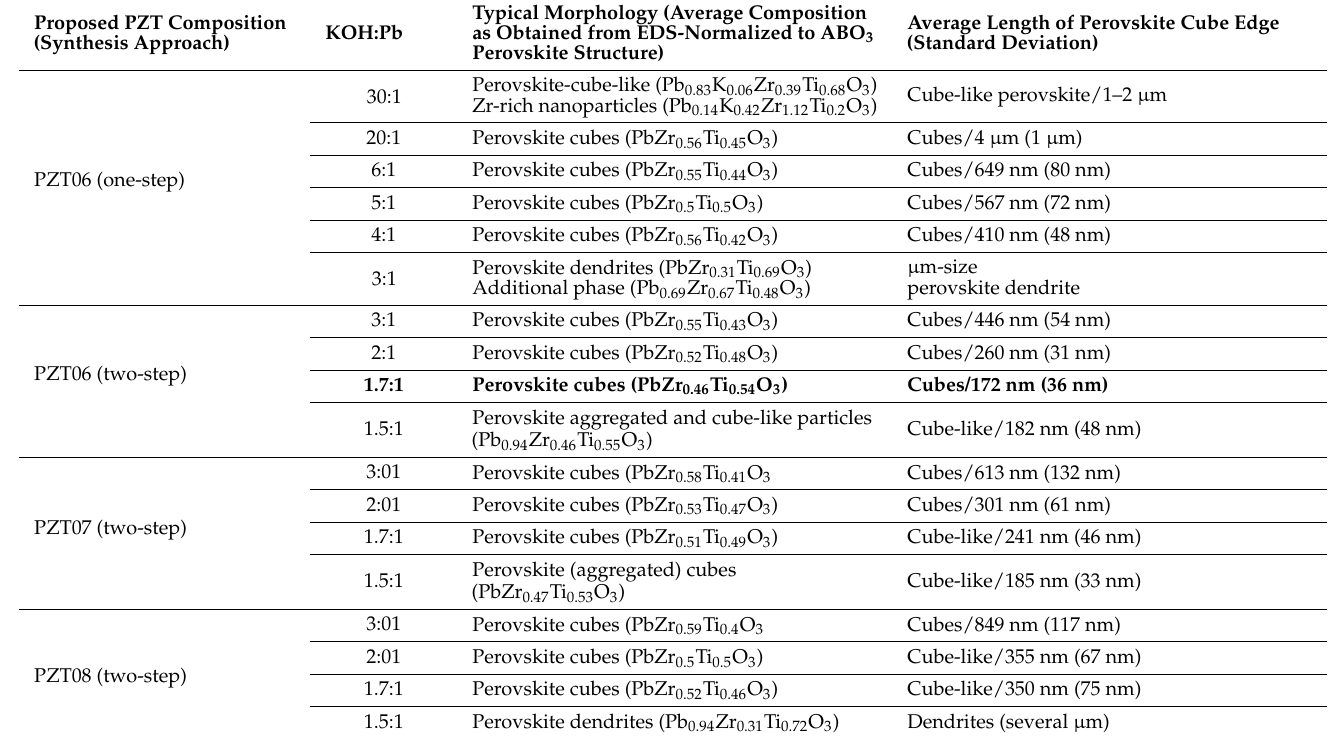
Table 2. Summary of the main characteristics of the PZT crystallites obtained by the one-step or two-step precipitation approach at different KOH:Pb